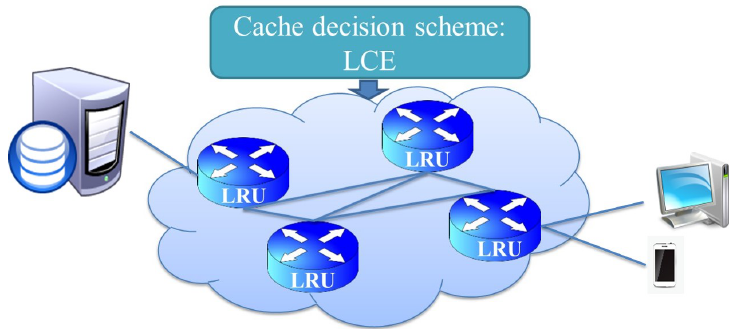
Figure 1. Default cache management scheme in Named Data Networking (NDN). LCE: Leave Copy Everywhere; LRU: Least Recently